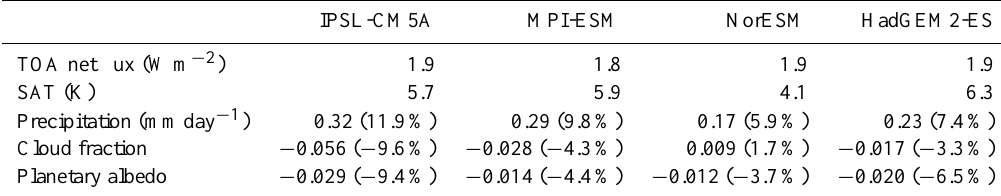
Table 4. Comparison of differences between the 4x × CO 2 and preindustrial climates (abrupt4xCO2 – piControl) in globally-averaged parameters. Note that in the case of 4 × CO 2 , averages are calculated over years 101 to 150, during which the simulated climate has not yet reached an equilibrium.